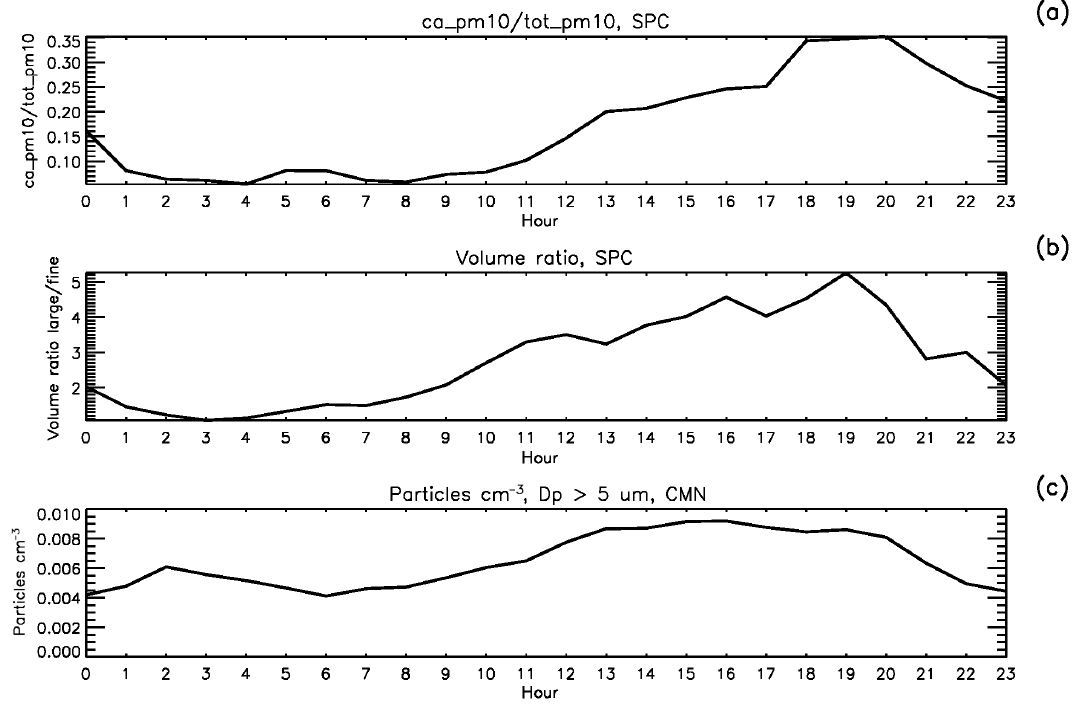
Figure 10. Panel (a) shows the mean daily evolution of the ratio of PM 10 concentration of the calcium ion (Ca 2 + ) over the total PM 10 ion concentration (Ca 2 + + PM 10 / total PM 10 ) in SPC. Panel (b) reports daily mean of the ratio of large particles (1µm <D p < 5.5µm) over the fine ones (0.5µm <D p < 1µm) at SPC, while panel (c) shows the daily mean of coarse ( D p > 5µm) particles at CMN. Each mean is computed on dust-free days.